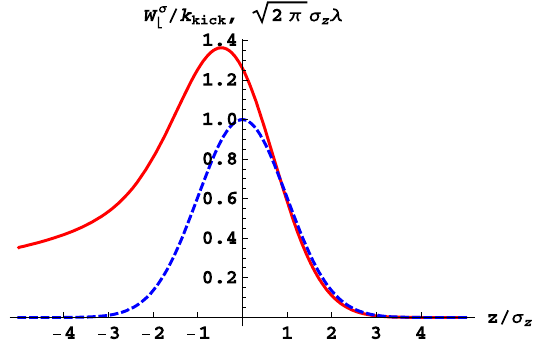
FIG. 2. (Color) Transverse wake potential (solid) and beam density (dashed); head of the bunch is z > 0 ; k kick > 0 is given by Eq.